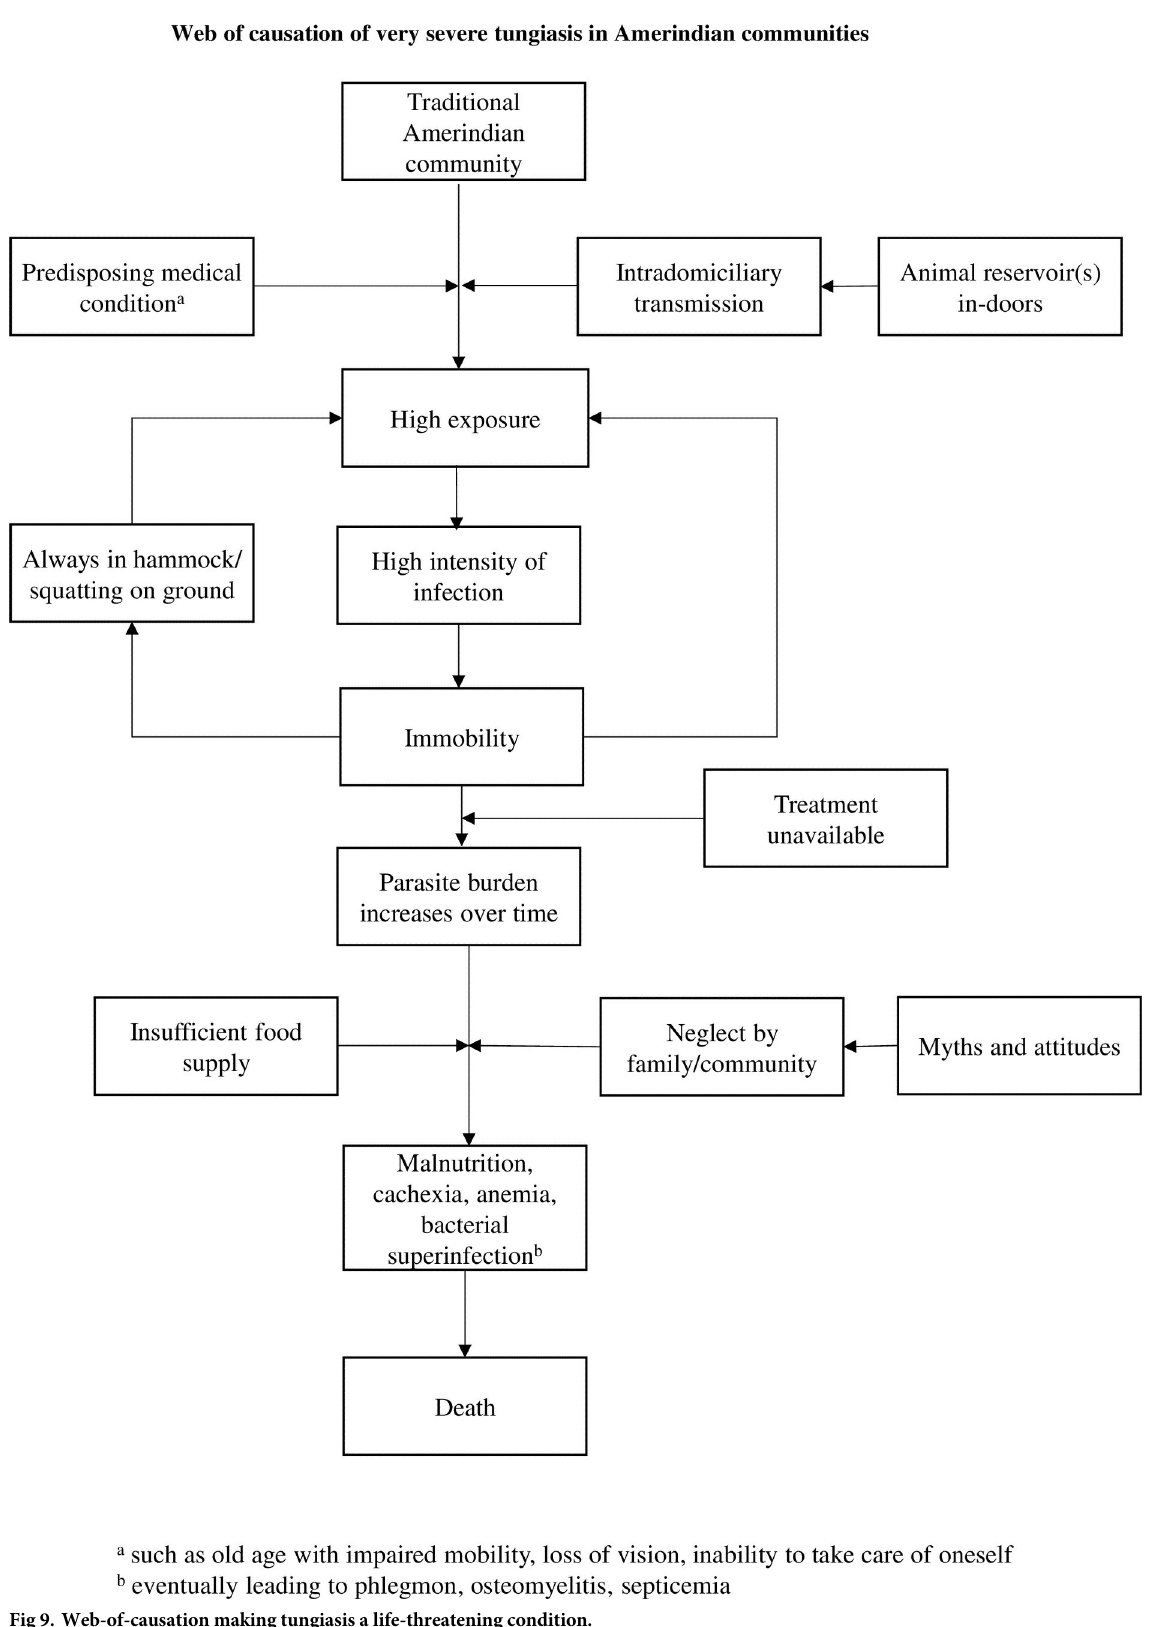
Fig 9. Web-of-causation making tungiasis a life-threatening condition.